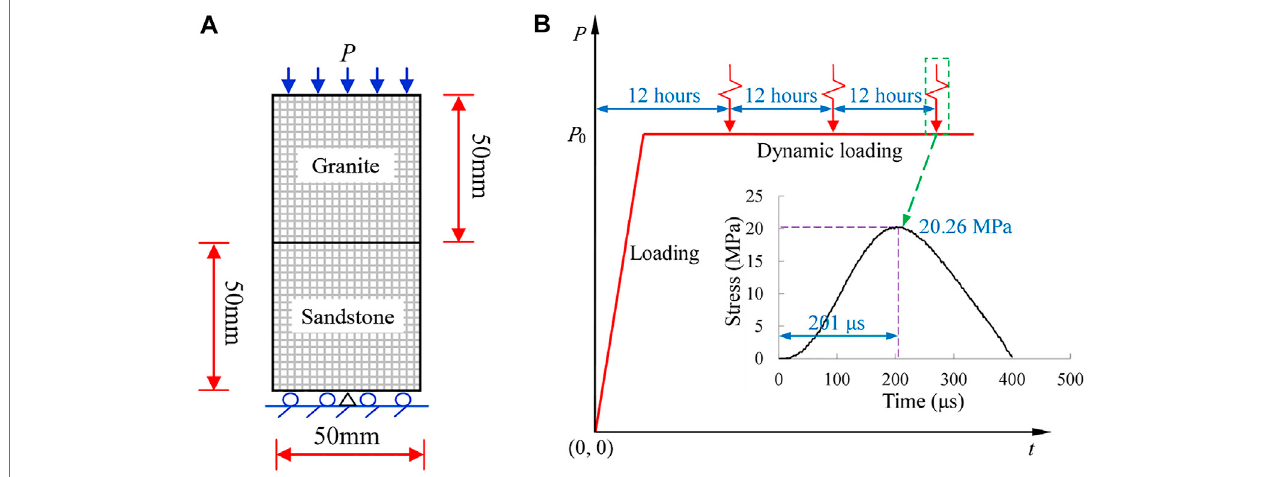
FIGURE 3 | Model setup for numerical simulation on interbedding rock specimen under creep with dynamic disturbance: (A) numerical model of double-rock sample, (B) Possible loading history on numerical model.